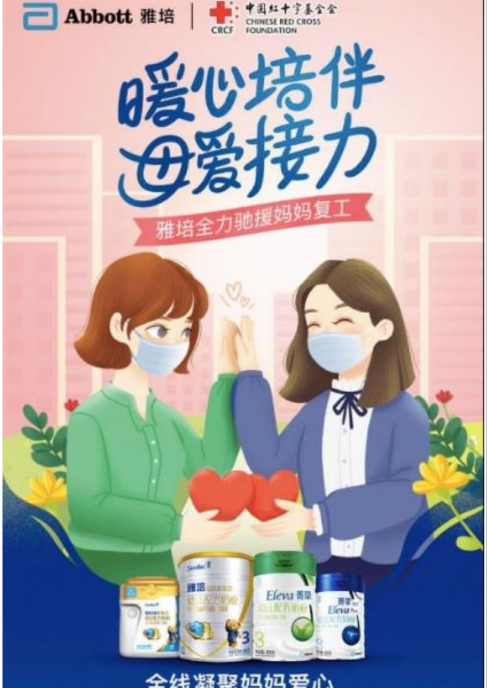
Figure 4. A screenshot from an online news portal in China of Abbott’s campaign with the Chinese Red Cross Foundation. The e-poster featured the slogan “A warm heart to keep you company and to carry on with the love of a mother: Abbott fully supports mothers returning to work” (translated from Chinese) and BMS